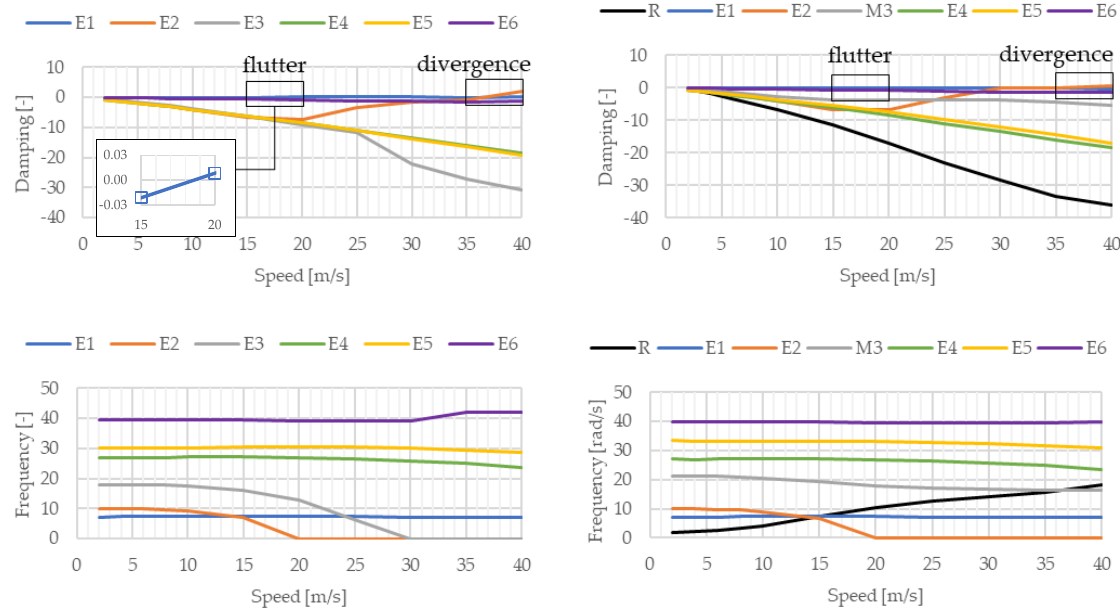
Figure 19. Flutter analysis results for the tandem-wing architecture under clamped ( left ) and free symmetric flight ( right ) conditions. Table 7. First modes observed in the flutter analysis of the tandem-wing architecture (R: mostly rigid; E: mostly elastic; M: mixed rigid-elastic).